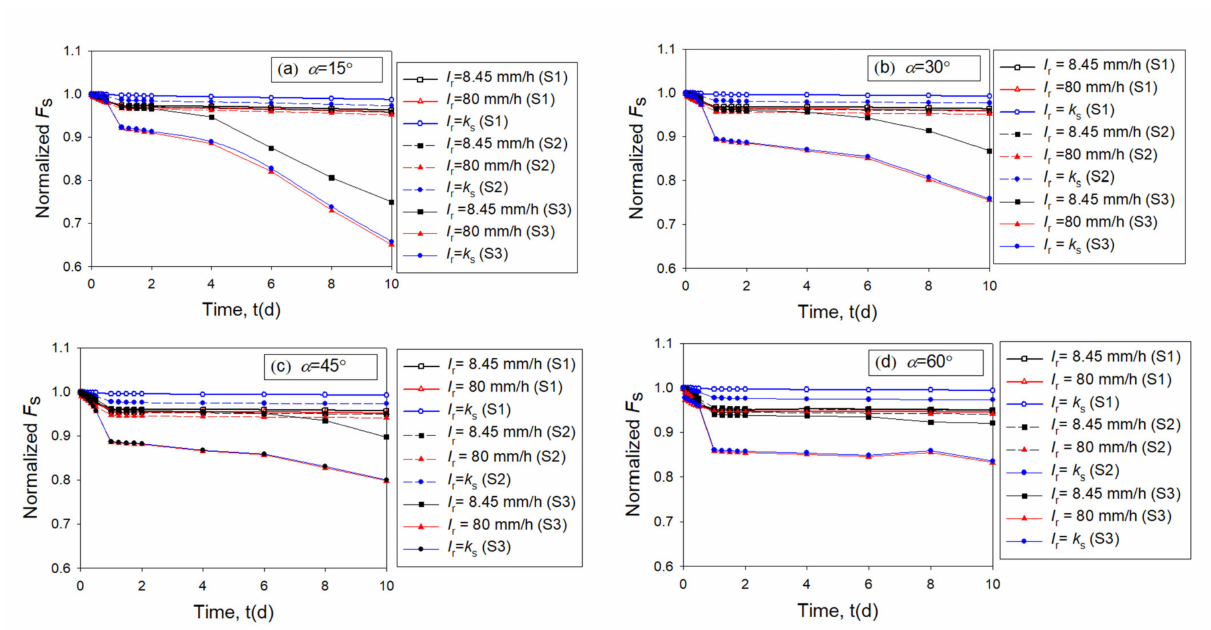
Figure 8. The normalized F s for different slopes under different conditions, ( a ) α = 15 ◦ ; ( b ) α = 30 ◦ ; ( c ) α = 45 ◦ ; ( d ) α = 60 ◦